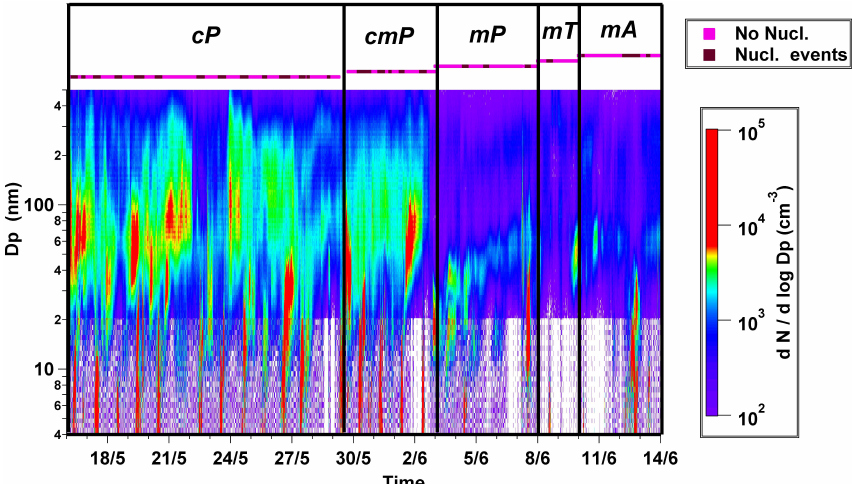
Fig. 6. Aerosol size distributions from the combined nano-SMPS and SMPS. Air mass types are highlighted as are nucleation and non- nucleation events.